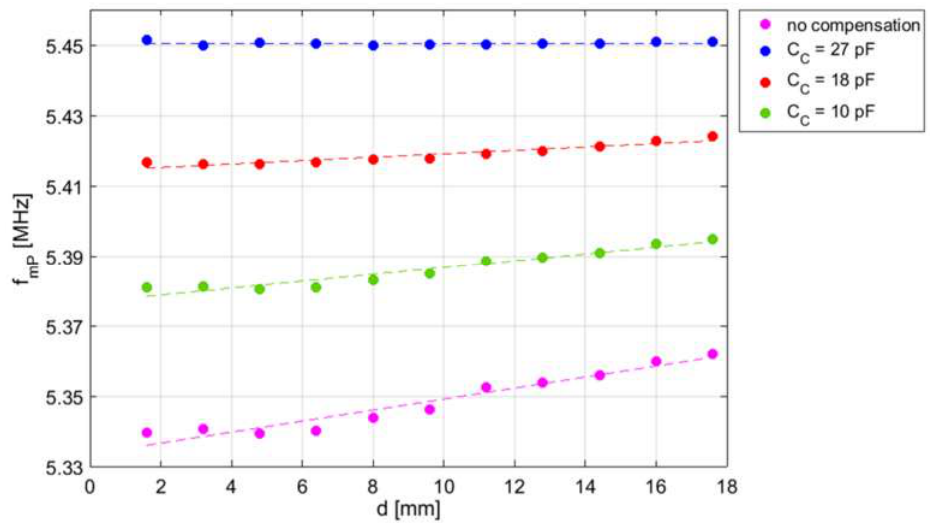
Figure 19. Measured frequency f mP as a function of d for different values of C C . The no compensation data are extrapolated from experimental values.